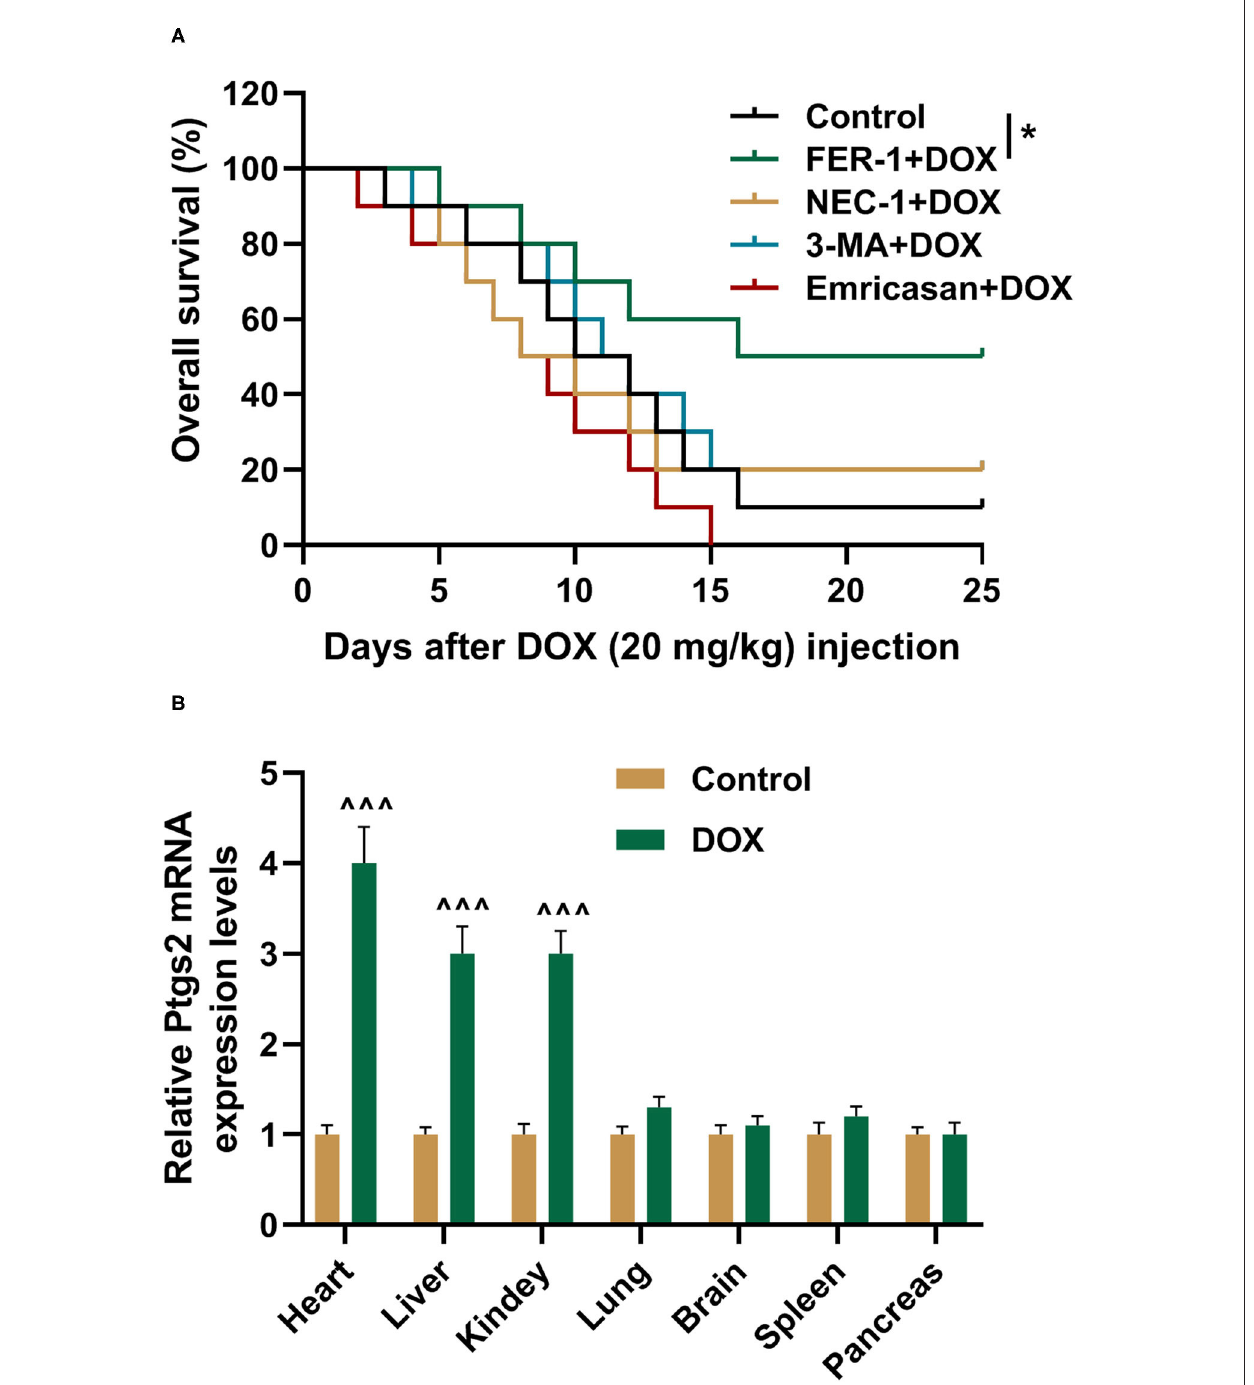
FIGURE 1 | FER-1 is found to decide DOX-induced mortality. (A) The survival rate of rats from different groups was shown by Kaplan–Meier survival analysis. All rats were injected with DOX (20 mg/kg). Ten rats were recruited in each group. (B) qRT-PCR analysis shows the mRNA expression level of PTGS2 in the indicated organs of rats after injection with saline (Control) and DOX (20 mg/kg) for 4 days with 10 rats in each group. Each experiment was repeated three times. ∧∧∧ P < 0.001 vs. control. * P < 0.05 vs. DOX. DOX, doxorubicin; FER-1, a ferroptosis inhibitor; NEC, a necrosis inhibitor; 3-MA, an autophagy inhibitor; Emricasan, a pan-caspase